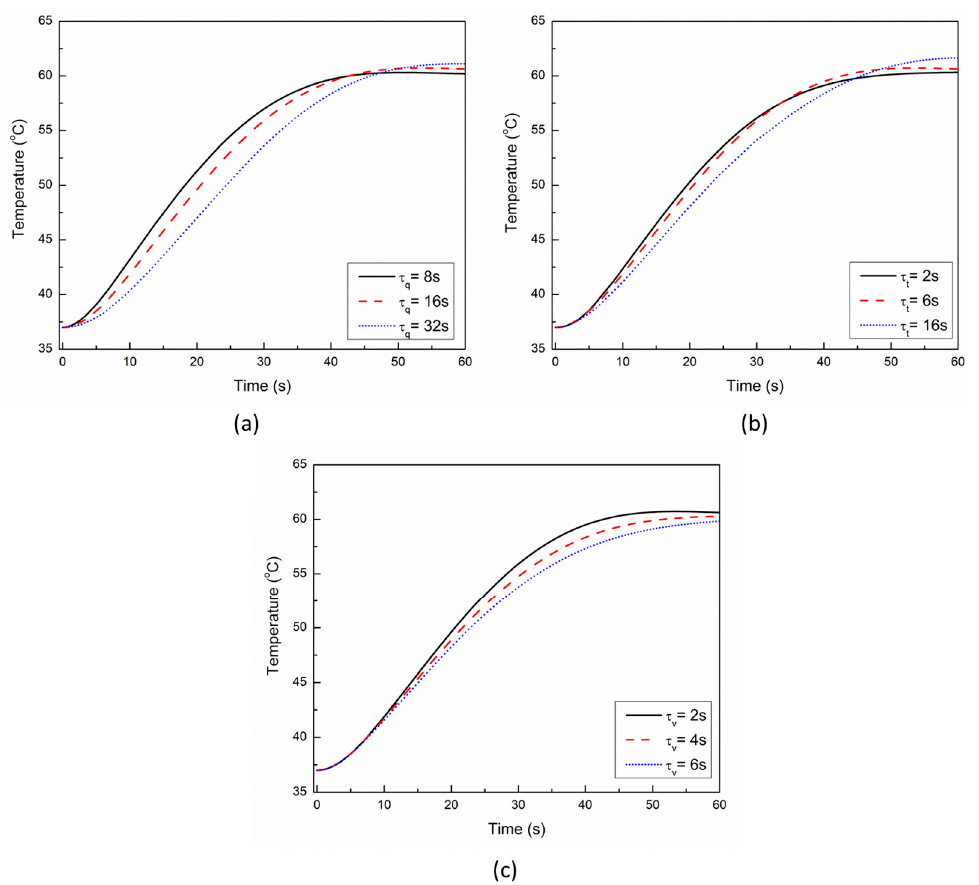
Figure 8. Effect of magnitude of ( a ) τ q , ( b ) τ t , and ( c ) τ v on the time-history of temperature at a location of 1 mm below the tip of the applicator.